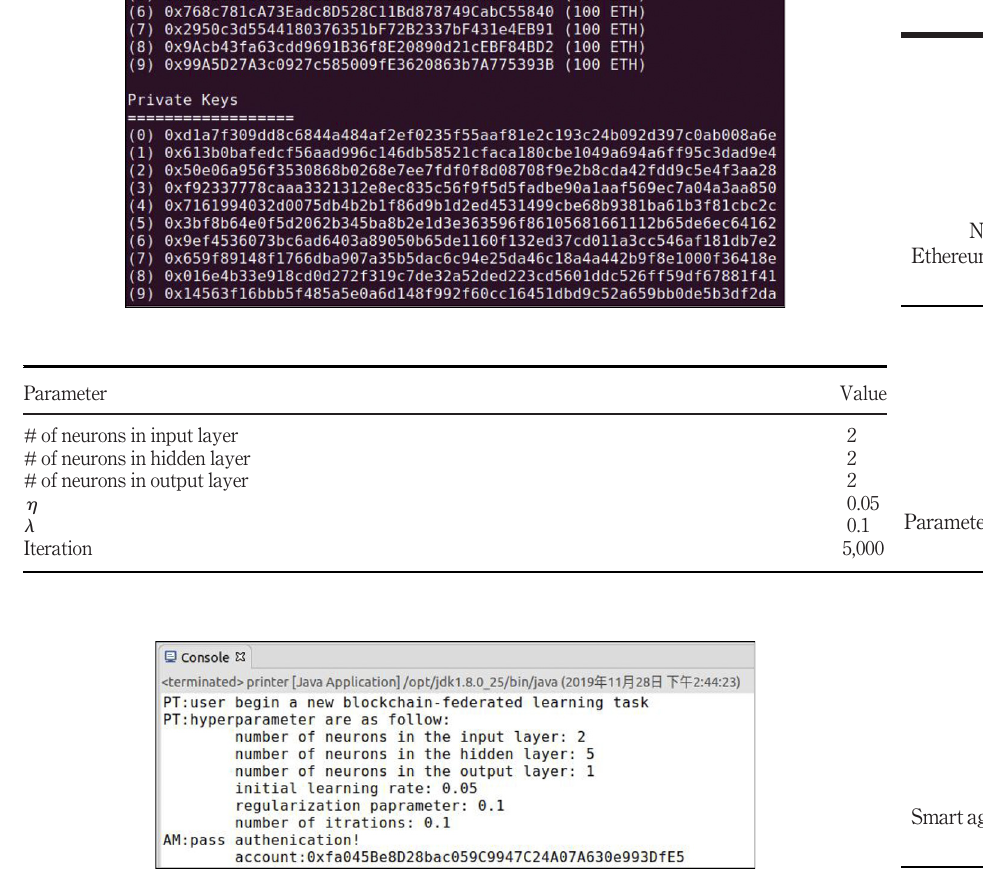
Figure 7. Nodes in local